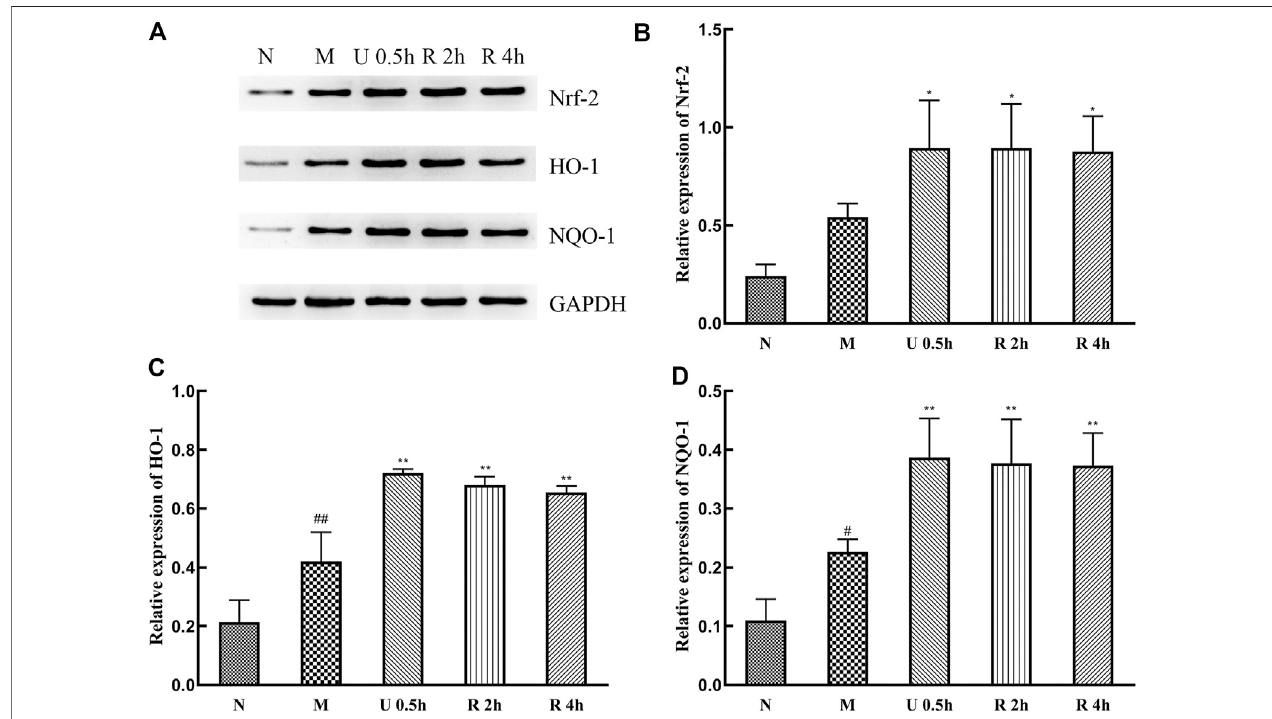
FIGURE8| WesternblotdetectionofNrf-2signalingpathwayandrelatedproteins (A) ,RelativeexpressionofNrf-2 (B) ,HO-1 (C) andNQO-1 (D) protein( x ± s, n (cid:1) 6). Compared with group N, # p < 0.05, ## p < 0.01; compared with group M, * p < 0.05, ** p < 0.01.